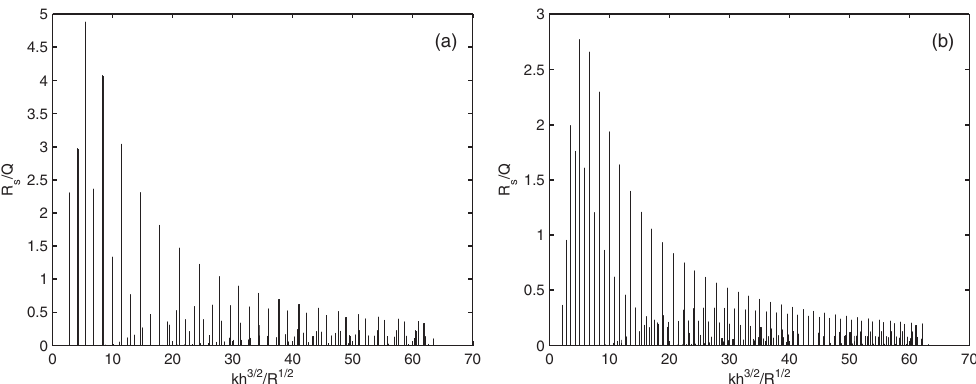
ˆ k for rectangular chamber with an aspect ratio (a) A ¼ 2 with 112 resonances and